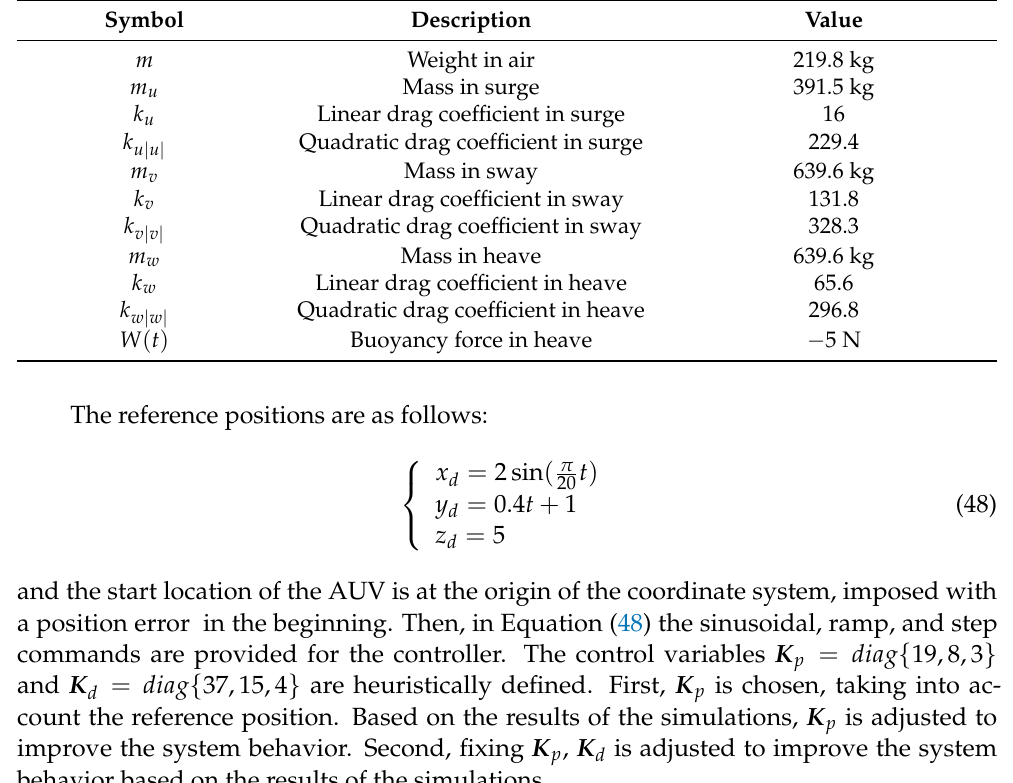
Table 2. The parameter